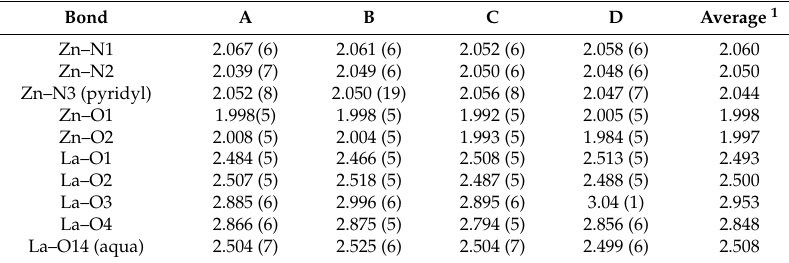
Figure 1. ORTEP diagrams of Zn 2+ /La 3+ complex ( 3 ) showing ( a ) perspective view; ( b ) top view, along c -axis; and ( c ) side view, along b -axis. 50% probability ellipsoids, H-atoms omitted. Shown is one of four nearly identical crystallographically independent molecules. Table 1. Selected metal-ligand bond distances in Å.